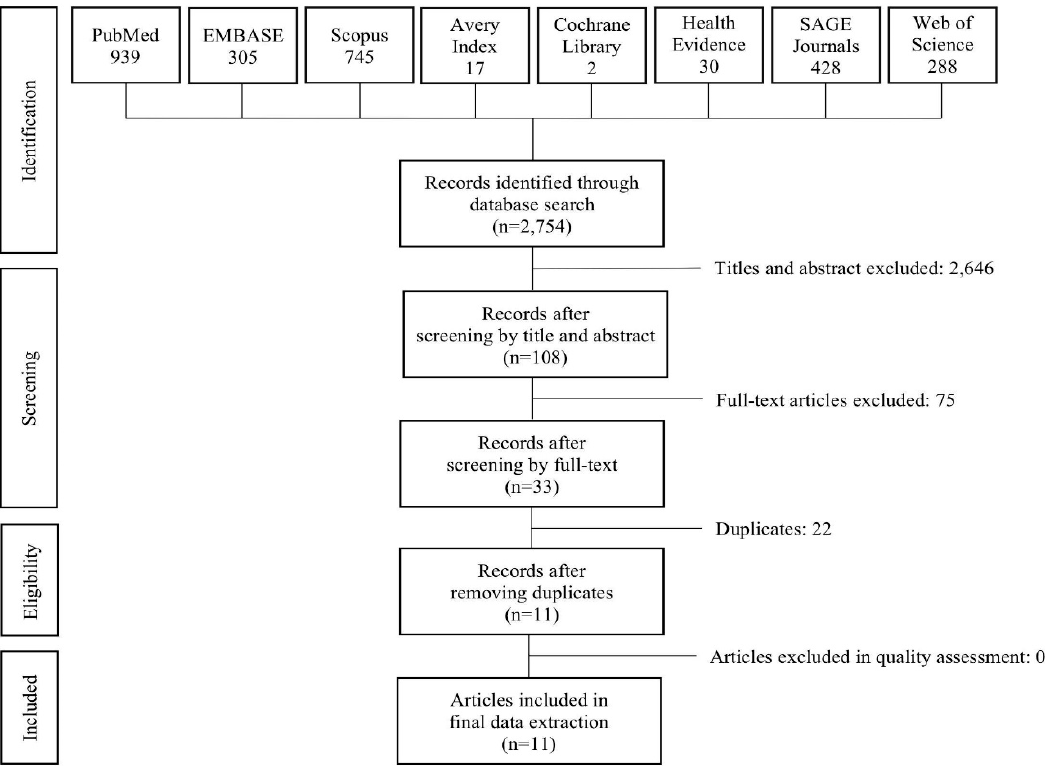
Figure 1. Flowchart of selection process of the reviews.